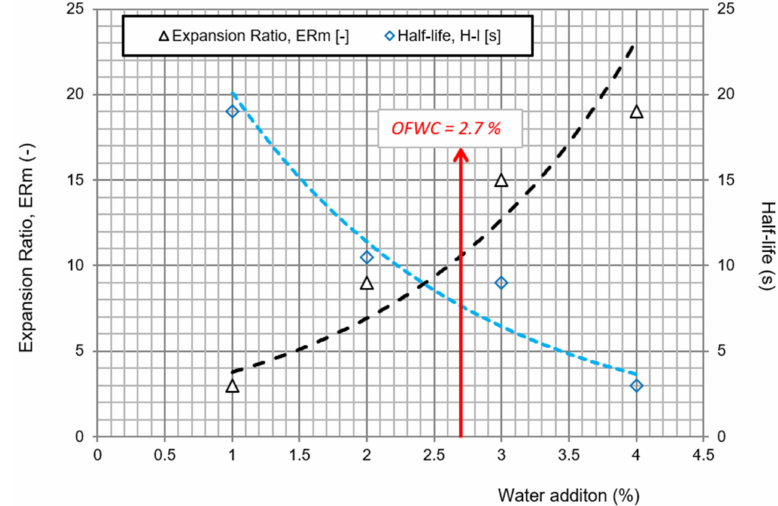
Figure 5. Determination of the optimum foaming water content for 70 / 100 bitumen.